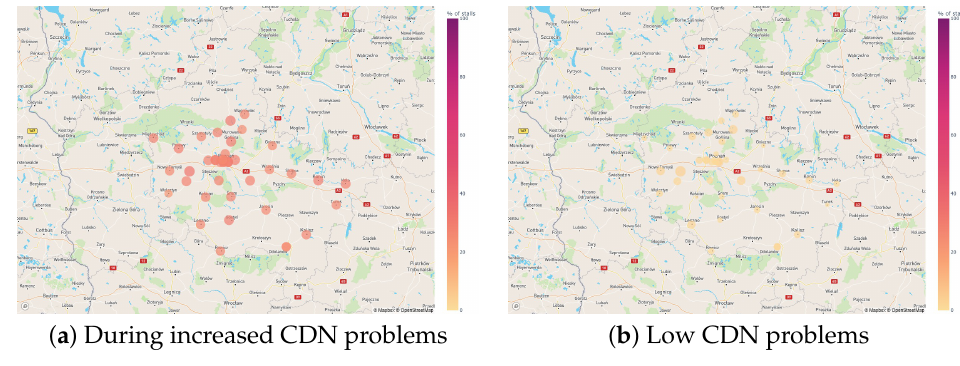
Figure 6. Percentage of